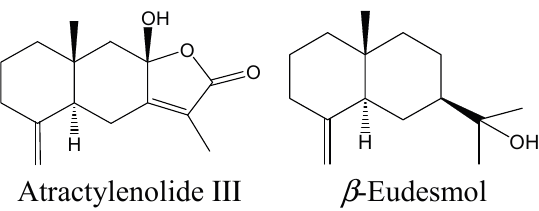
Figure 2. Chemical structures of atractylenolide III and β -eudesmol.